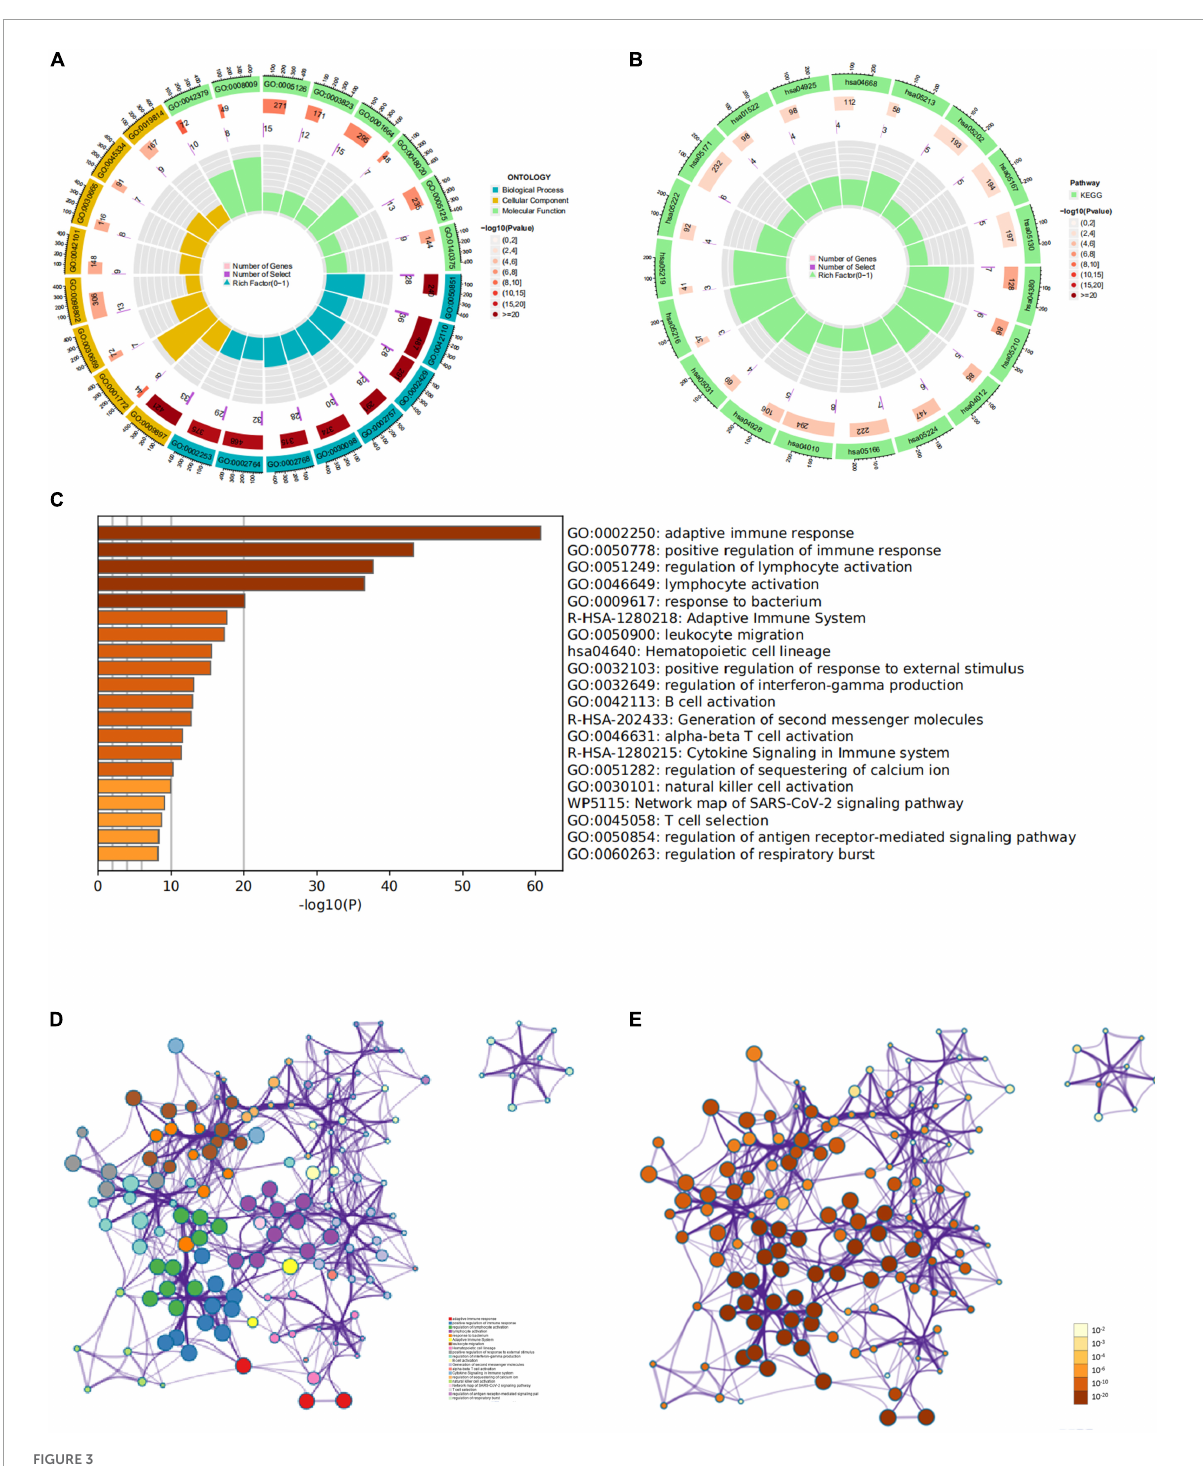
FIGURE3 Functional and pathway enrichment analysis of upregulated genes. (A) Gene ontology (GO) enrichment analysis. (B) Kyoto encyclopedia of genes and genomes (KEGG) enrichment analysis. (C) Heatmap of Metascape enrichment analysis. (D) Differentially expressed genes (DEGs), colored by cluster ID. DEGs in the same cluster ID node are closely related to each other. (E) DEGs colored by P -value. Terms with more significant P -values contain more